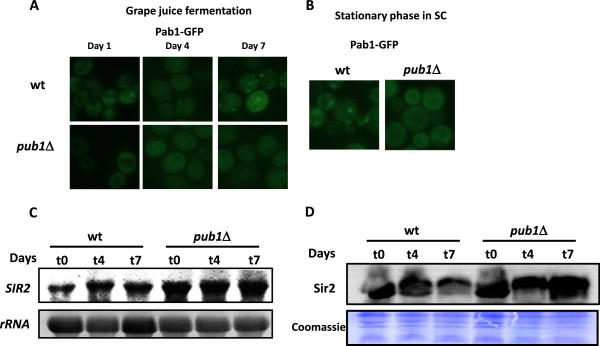
Pub1 is necessary for stress granule (SG) formation and regulates Sir2 expression during grape juice fermentation. A) SG formation during grape juice fermentation. A Pab1-GFP fusion was inserted in the EC1118 wild type strain and its pub1Δ derivative and its fluorescence was observed at days 1, 4 and 7 of grape juice fermentation. B) SG formation at stationary phase in SC medium. The same strains were grown for three days in SC, the reference point for CLS experiments in laboratory conditions. C) Northern blot analysis of the SIR2 mRNA levels during grape juice fermentation for the EC1118 strain and its pub1Δ derivative. rRNA is used as the loading control. D) Western blot of Sir2 protein in the same conditions of section C). Coomassie blue staining was used as the loading control.